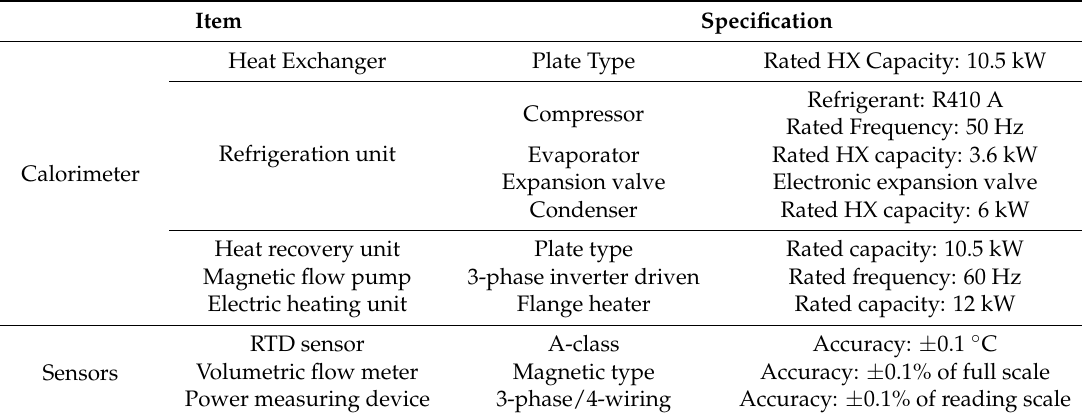
Table 1. Specification of calorimeter and